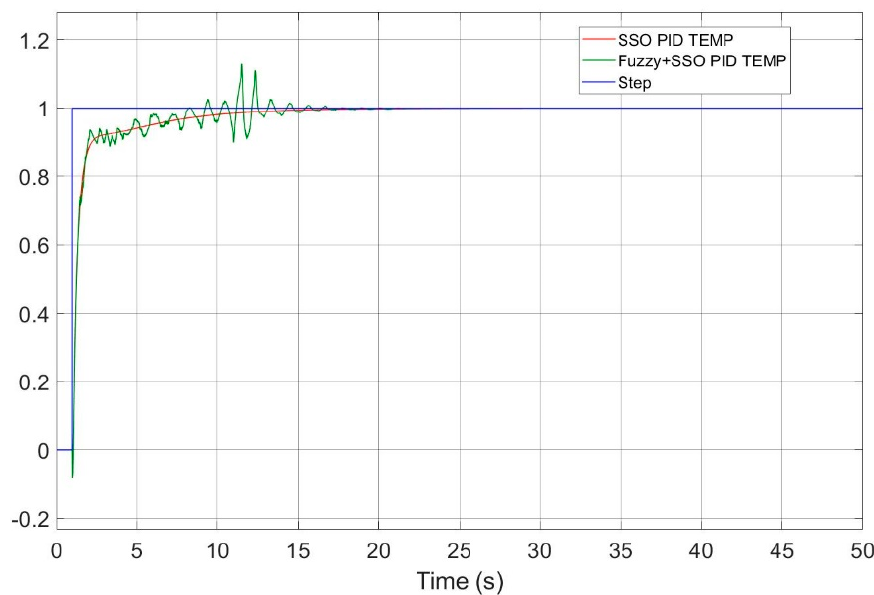
Figure 21. Temperature versus time plot for PID tuned with SSO and SSO fuzzy.